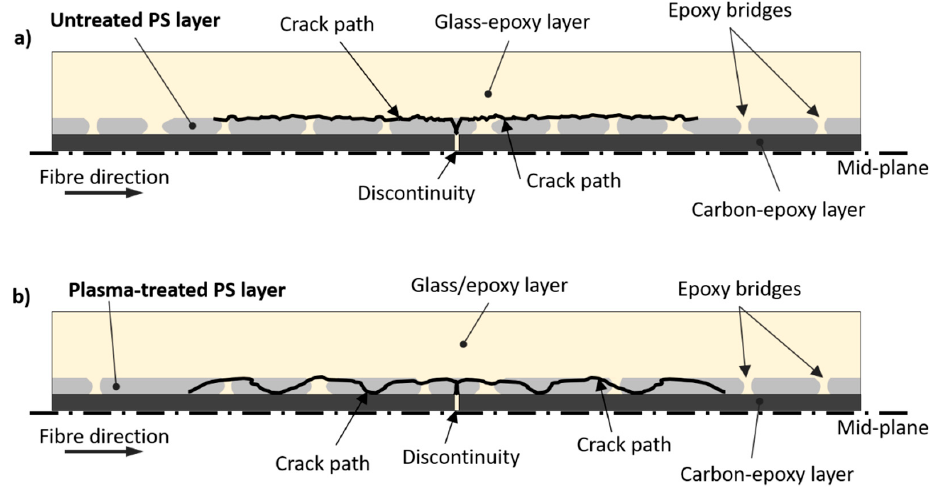
Figure 14. Representation of the crack path in PS-interleaved hybrid composites. The configuration with untreated PS is shown in ( a ) and the configuration with plasma-treated PS in ( b